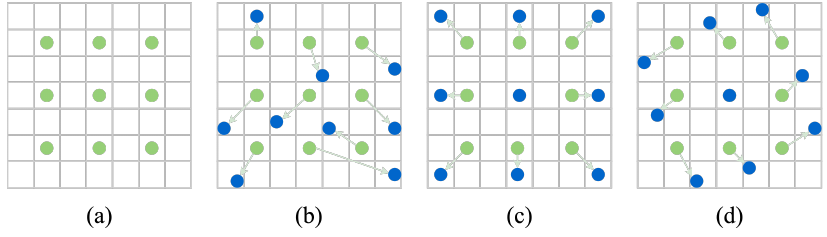
Figure 7. Illustration of the sampling locations in 3 × 3 standard and dilated–deformable convo- lutions. ( a ) Regular sampling grid (green dots) for standard convolution. ( b ) Dilated–deformable sampling locations (dark blue dots) with enhanced offset (light blue arrows) in the dilated–deformable convolution. ( c , d ) Particular cases of ( b ), showing that the dilated–deformable convolution gen- eralizes the various transformations of the scale, (anisotropic) aspect ratio, and rotation [34]. The dilated–deformable improves on the deformable